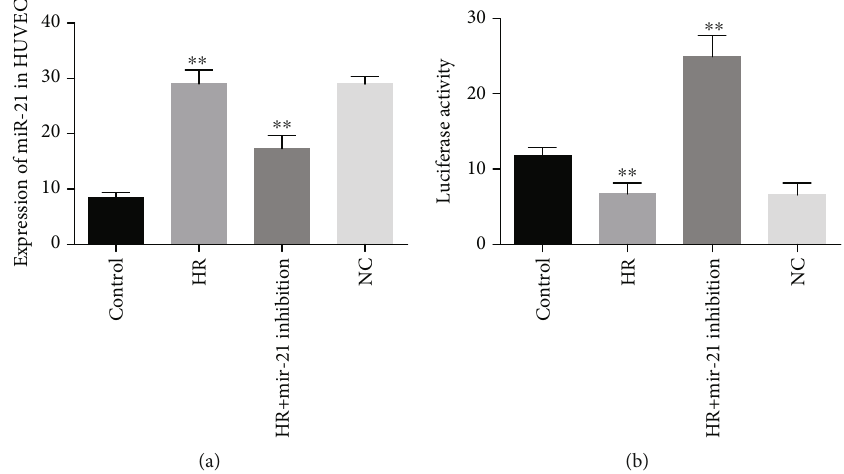
Figure 3: Expression patterns of mir-21 in HUVECs and luciferase analysis to determine the target: (a) the mir-21 expression levels in healthy and HR groups; (b) reporter gene assay luciferase expression levels in normoxic, HR, HR with transfected mir-21, and NC groups in HUVECs standardized by Renilla reniformis. ∗∗ P < 0 : 001